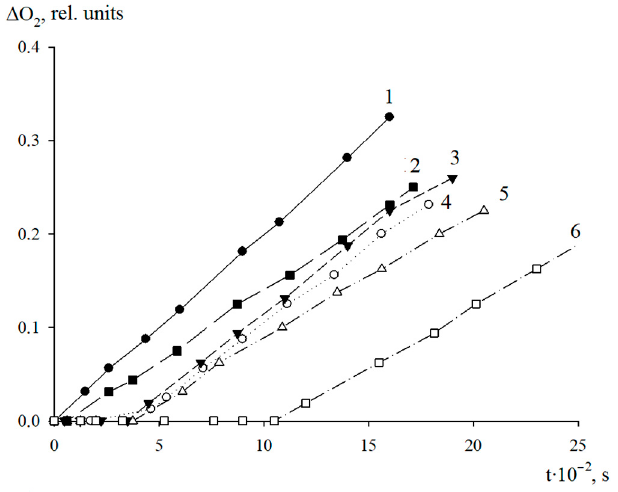
Figure 5. Typical kinetic curves of the oxygen uptake during the oxidation of 1,4-dioxane in the absence (1) and in the presence of AO2 taken in concentrations, mol/L: 0.44 × 10 − 6 (2); 0.94 × 10 − 6 (3); 1.25 × 10 − 6 (4); 1.88 × 10 − 6 (5); 3.13 × 10 − 6 (6). T = 348 K, V i = 1 × 10 − 7 M/s. Table 5. Dependence of the initial oxidation rate of ethylbenzene on the concentration of AO1 and AO2; V i = 1 · 10 − 7 M/s, T = 348 K.